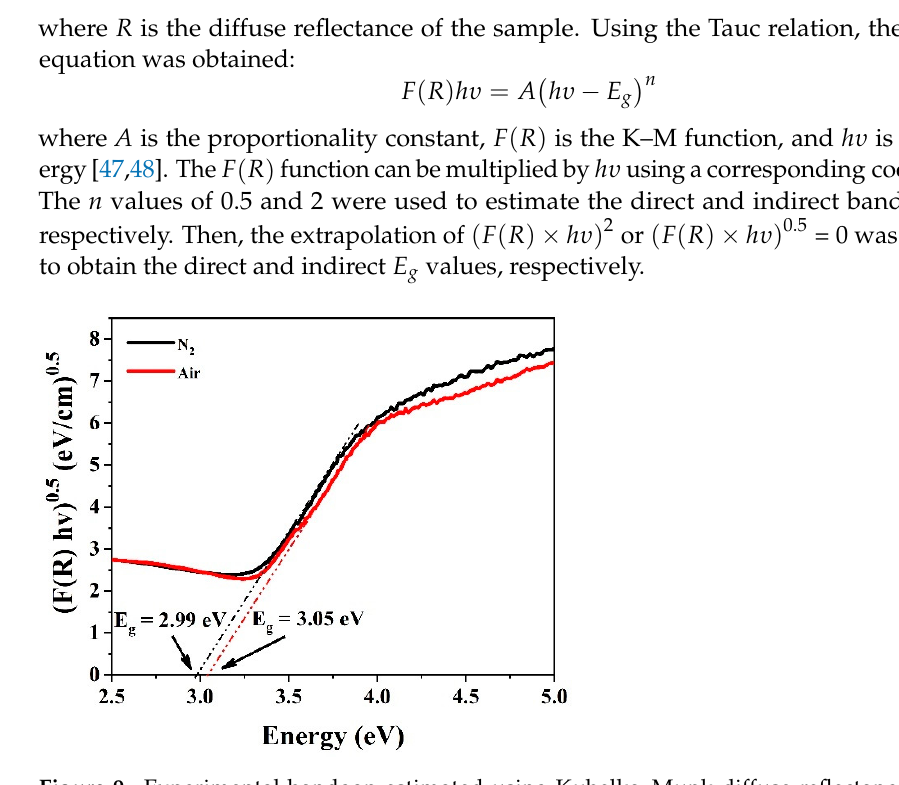
Figure 9. Experimental bandgap estimated using Kubelka–Munk diffuse reflectance solid state UV–Vis equation for TNTs annealed in nitrogen and air.